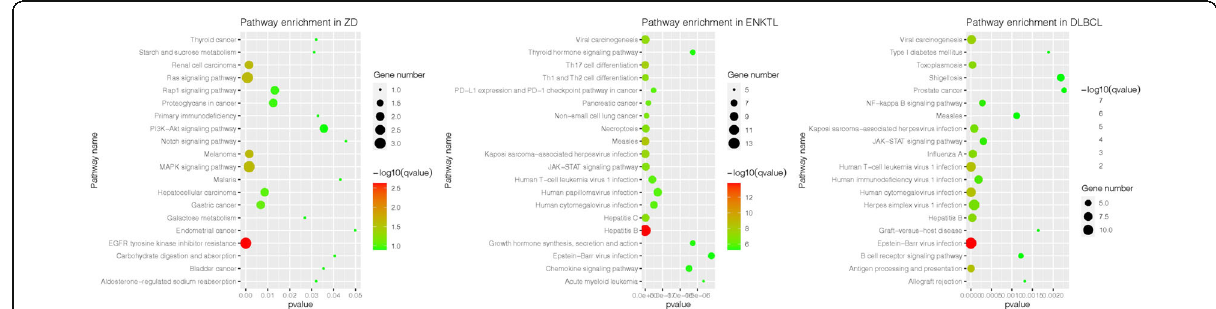
Fig. 6 The cluster Profiler of KEGG enrichment analysis (The size of the bubble represents the gene numbers, and depth of color represents enrichment p -value. The nearer to red represents a smaller p- value. We found they were three different enriched signaling pathways